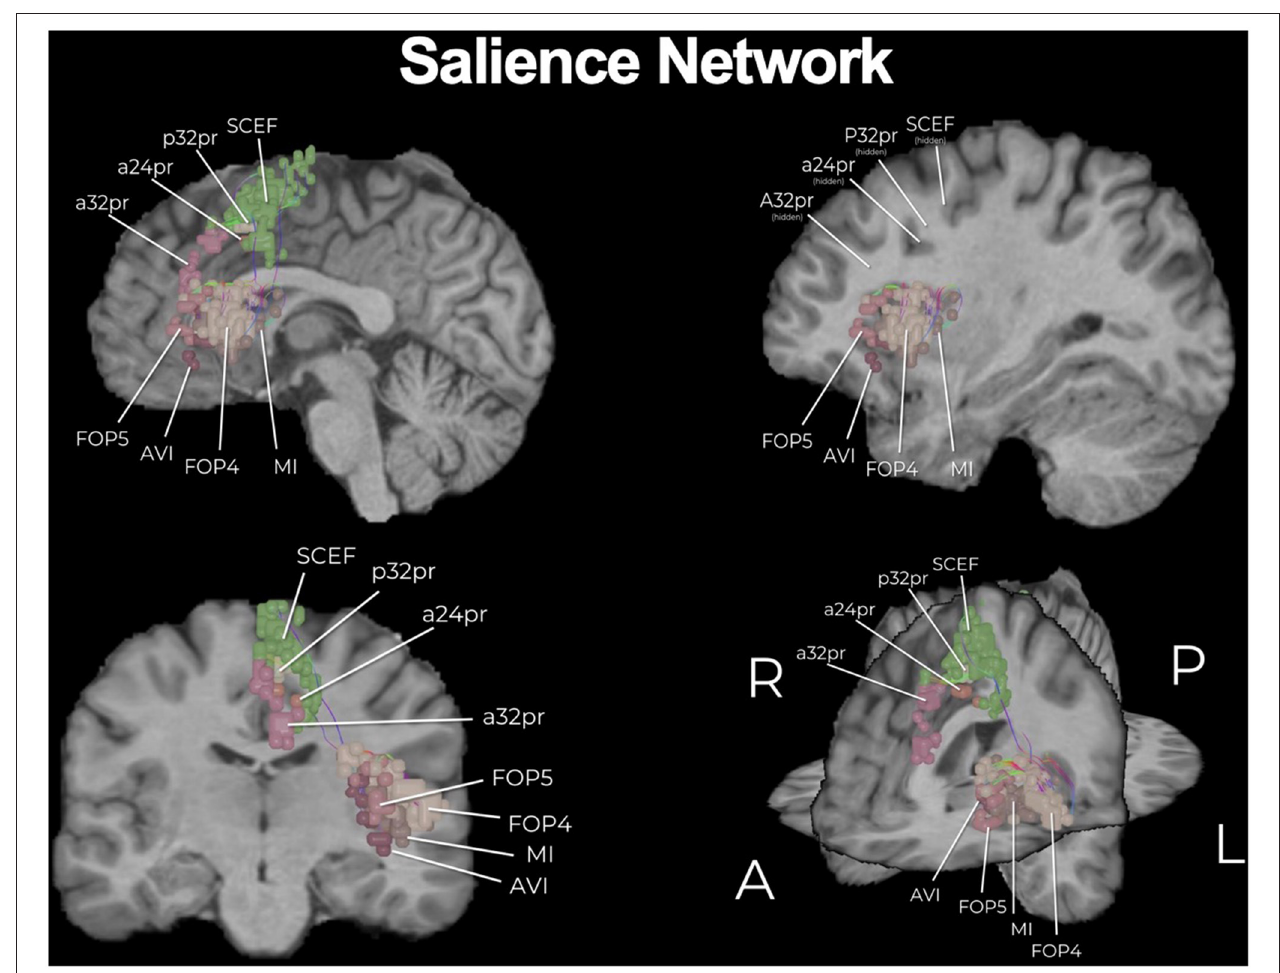
FIGURE 2 | The core of the salience network (SN). Similar to the DMN, the SN is a multi-lobar network and here we show its core. Individual regions have been visualized in 3D space and therefore some parcellations have been covered or require multiple views for correct spatial understanding due to parallax. Visualization of tracts have been minimized (thickness and volume) to maximize the visibility of